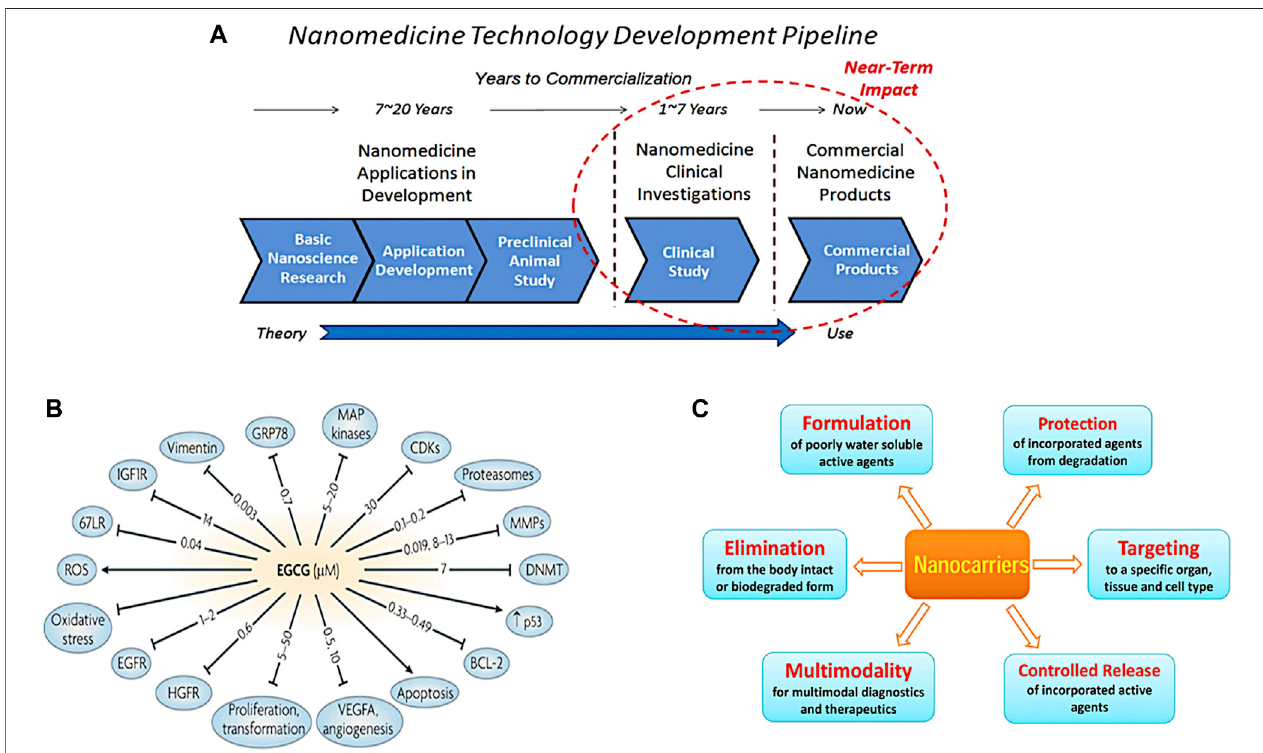
FIGURE 14 | (A) The fi ve steps that need to be undertaken before a new nanomedical application is ready for clinical use. (Figure adapted from (Etheridge et al., 2013)), (B) possible targets forEGCG (Figureadapted from (Yang et al.,2009)),and (C) theadvantages ofnanocarriersforuseincancertreatment(Figureadapted from (Chen G. et al.,